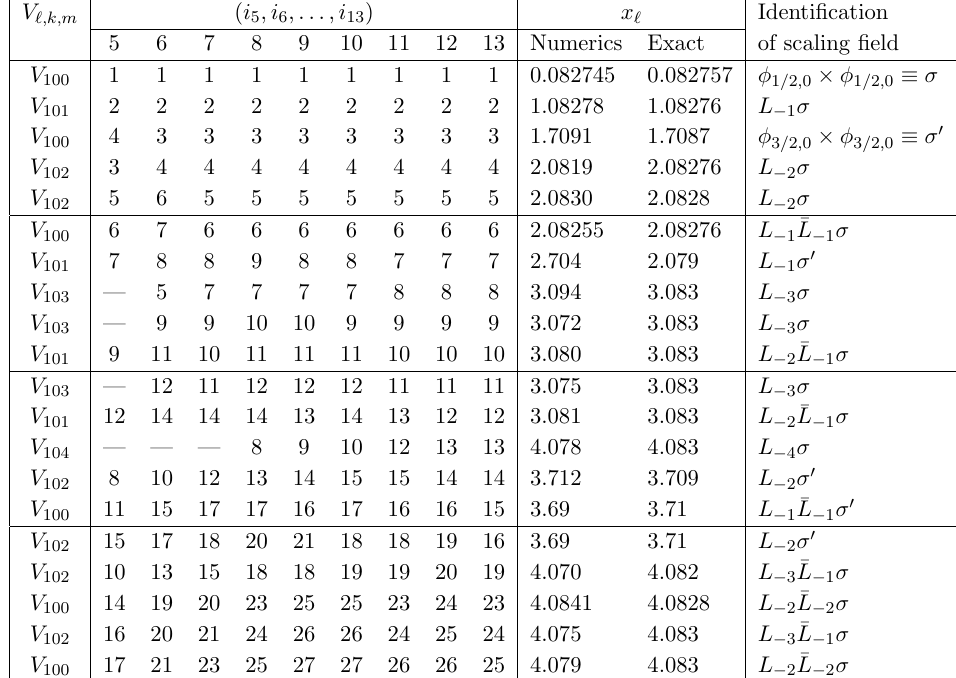
Table 2 . Conformal spectrum in the sector V 1 , for Q = 1